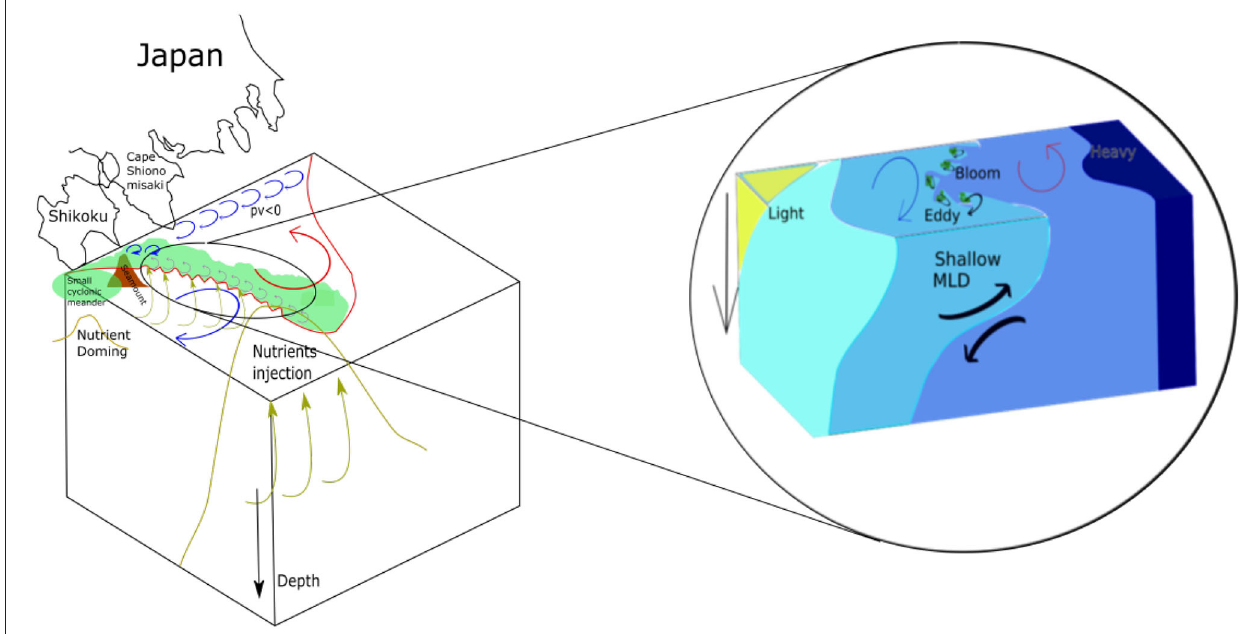
FIGURE 10 | Hypothesis to arise positive chlorophyll-a anomaly in the LM. The small cyclonic trigger meander slowly propagates eastward from the region south of Kyushu, and emerges as the LM off Enshu-Nada. The small cyclonic meander is expected to retain the nutrient doming structure accompanied by the surface chlorophyll-a positive anomaly. As the LM occurs, the Kuroshio flows closer to the coast in the region south of Kyushu, which could induce strong turbulent mixing and nutrient supply (Nagai et al., 2019a). Also, the small seamounts along the Kuroshio, and/or the strong westward counter current along the south coast of Enshu-Nada could produce negative potential vorticity, that can induce turbulence and inject domed subsurface nutrient to the upper layers. The mixed layer restratification seems to increase the phytoplankton on the western part of the